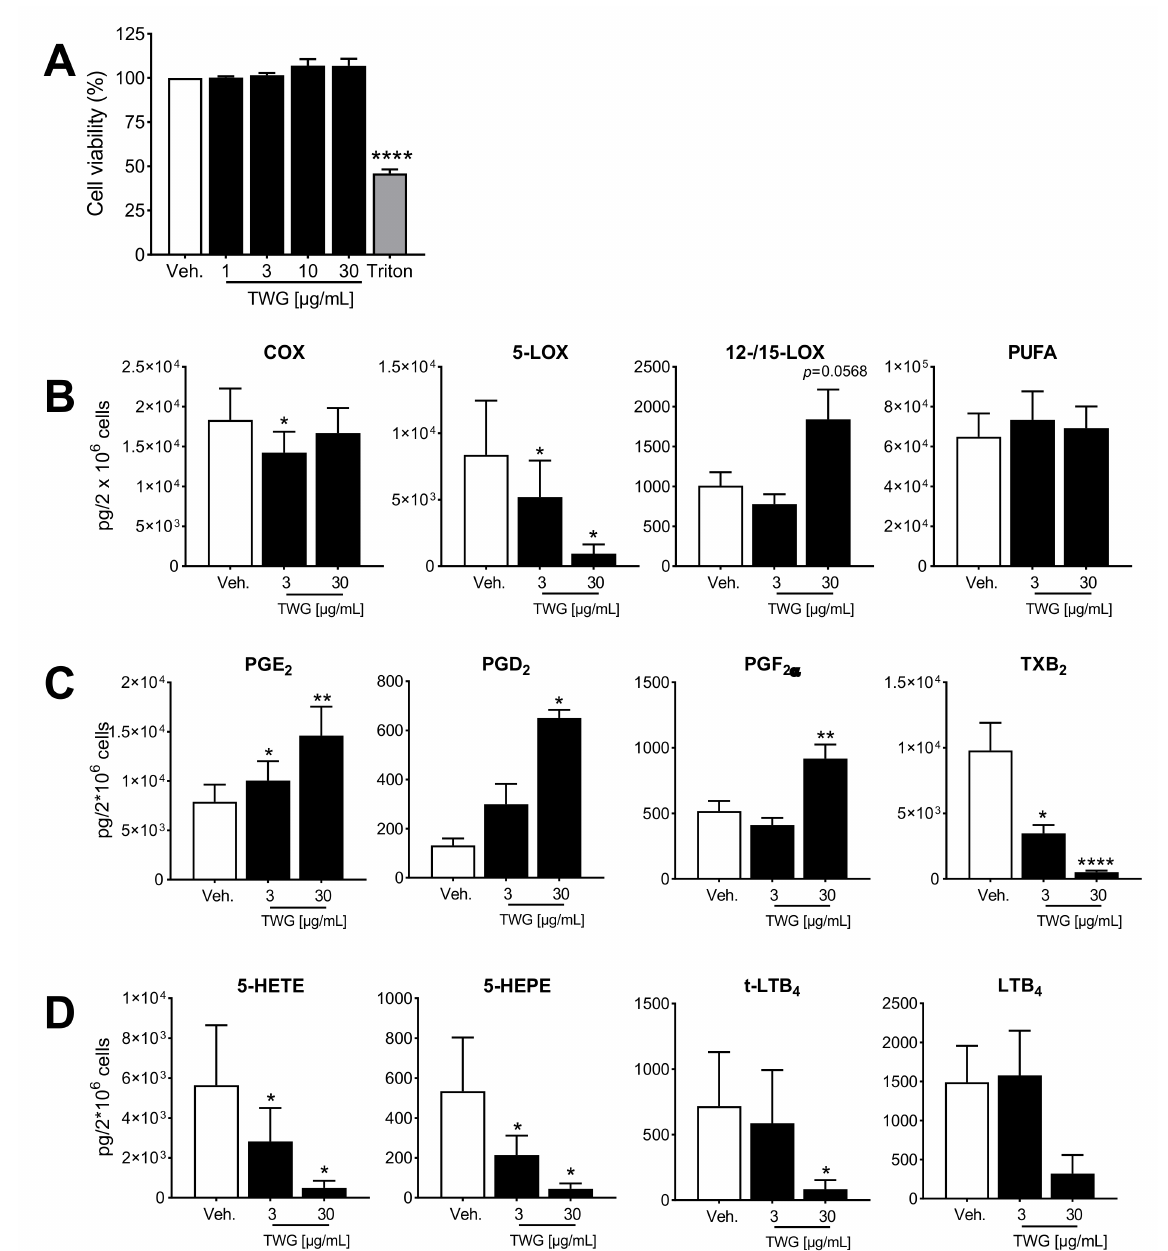
Figure 1. Effects of TWG on cell viability and LM modulation in human M1-MDM. ( A ) M1-MDM were treated with TWG at the indicated concentrations, 1% triton X-100, or 0.1% DMSO as vehicle for 3 h. Then, cell viability was assessed by MTT assay. Values are means + S.E.M., n = 3, expressed as percentage of vehicle control (=100%); **** p < 0.0001 TWG vs. control group, one-way ANOVA for multiple comparisons with Bonferroni’s correction. ( B – D ) M1-MDM were pre-treated with 3 and 30 µ g/mL TWG or 0.1% DMSO as vehicle for 15 min and then stimulated with 1% S. aureus -conditioned medium (SACM) for 90 min. Produced LM were analyzed by UPLC-MS-MS in the supernatants. ( B ) The sum of COX products, 5-LOX products, 12/15-LOX products, and PUFA are expressed as pg/2 × 10 6 cells of TWG-treated and vehicle-treated cells. ( C , D ) Individual members of COX products ( C ) and of 5-LOX products ( D ). Data are means ± S.E.M., n = 3 and were log-transformed for statistical analysis, * p < 0.05, ** p < 0.01, **** p < 0.0001, TWG vs. control group, one-way ANOVA and Dunnett’s multiple comparisons